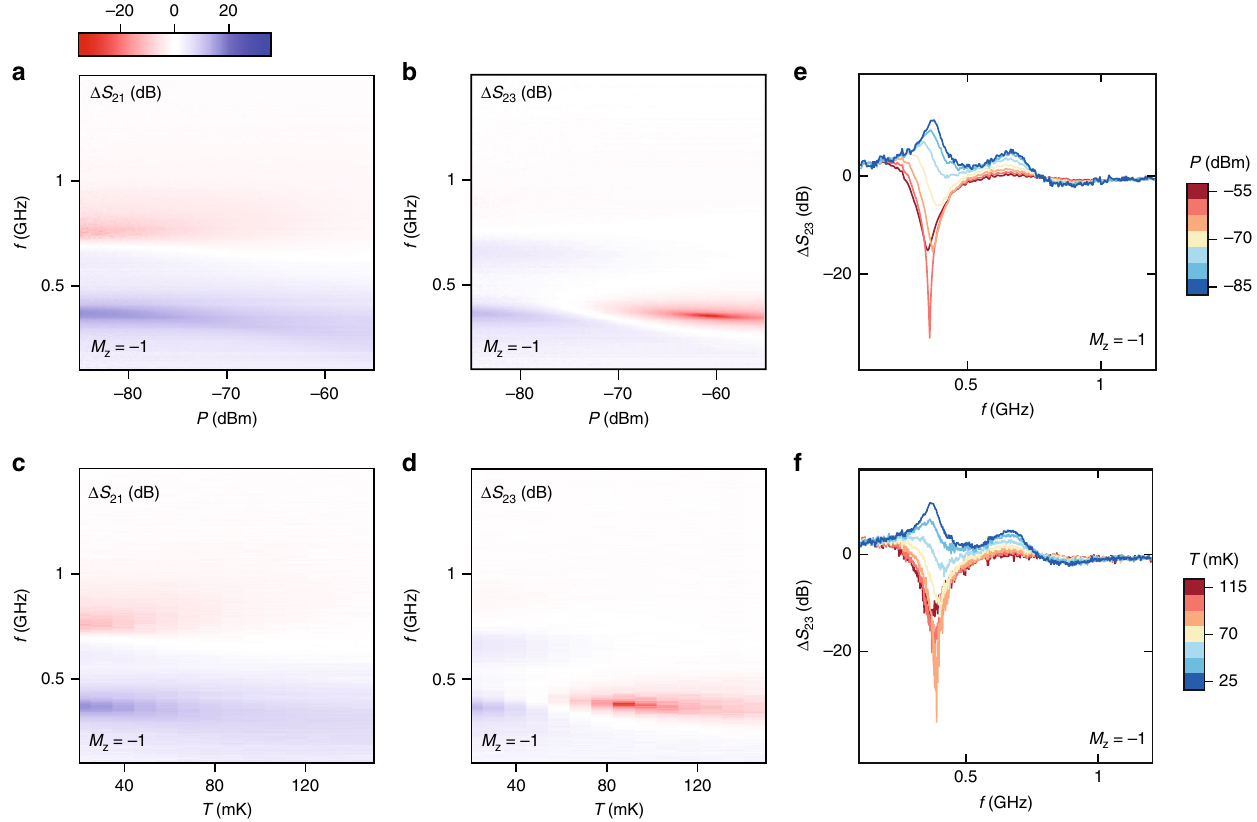
Fig. 4 Effect of temperature and microwave power. a , b Frequency response Δ S 21 and Δ S 23 with increasing microwave power applied to the excitation port. For these measurements T ~ 20 mK. In c , d the dependence of Δ S 21 and Δ S 23 is measured as a function of cryostat temperature while the applied port power is kept low at − 87 dBm. In a – f , all the data are taken at zero applied magnetic fi eld after the sample has been magnetised with M z = − 1. Akin to Figs. 2 and 3, the same pre-magnetisation background taken at constant power and cryostat base temperature is subtracted from each of the 2D plots. The colour scale represents Δ S (dB). e , f 1D cuts through the colour plots of Δ S 23 in b , d . The colour bar in e shows power (dB), while the colour bar in f indicates temperature